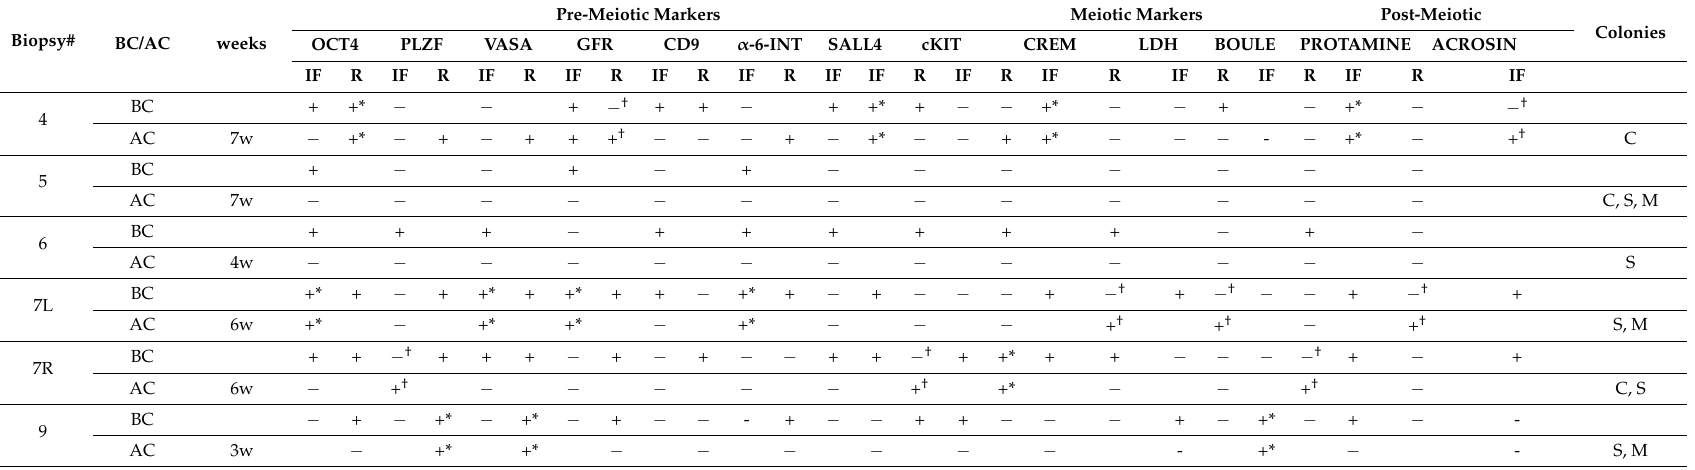
Table 3. Expression of spermatogenic markers in developed cells/colonies in MCS isolated from testicular biopsies without sperm of SCOS patients: Cells isolated from testicular biopsies without sperm ( n = 6) from SCOS patients were cultured for a number of weeks (w) in MCS in-vitro. Cells before and after culture in MCS were examined for the presence of spermatogenic cells by immunofluorescence staining (IF) or for expression markers (RNA; R) by PCR analysis using specific antibodies or primers (respectively) for each spermatogenic stage: premeiotic (OCT4, PLZF, VASA, GFRa1, CD9, α -6-Integrin, SALL4, and c-KIT), meiotic (CREM, LDH, and BOULE), and postmeiotic (protamine and acrosin). BC—before culture, AC—after culture, W—number of weeks in culture, C—cells, S—small colonies, M—medium colonies. Empty rectangle—indicates not examined. †—indicates markers that were not expressed before in vitro culture and positively expressed after in vitro culture in MCS. *—indicates markers that were expressed before in vitro culture and continued to be positively expressed after in vitro culture in MCS. ( − )—indicates negative expression, (+)—indicates positive expression. L—a biopsy from the left testis; R—a biopsy from the right